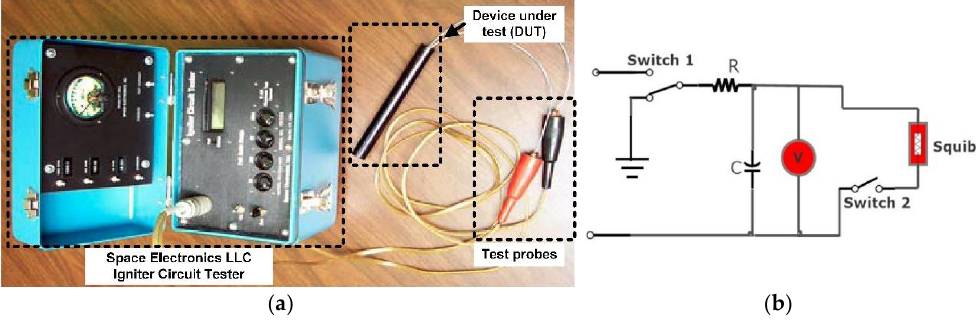
Figure 3. Squib electrical properties measurements. ( a ) Squib or ignitor tester; ( b ) squib or ignitor circuit.